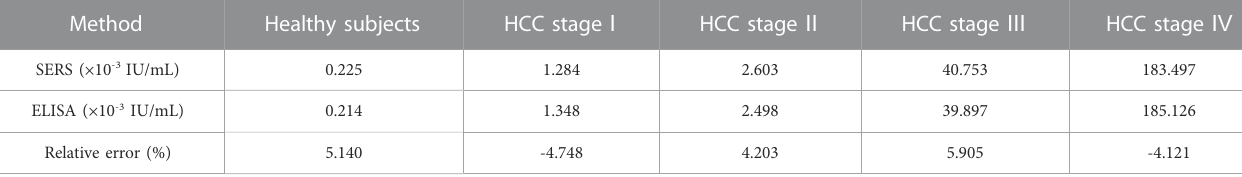
TABLE 3 Mean levels of telomerase activity in clinical blood samples from HCC patients.